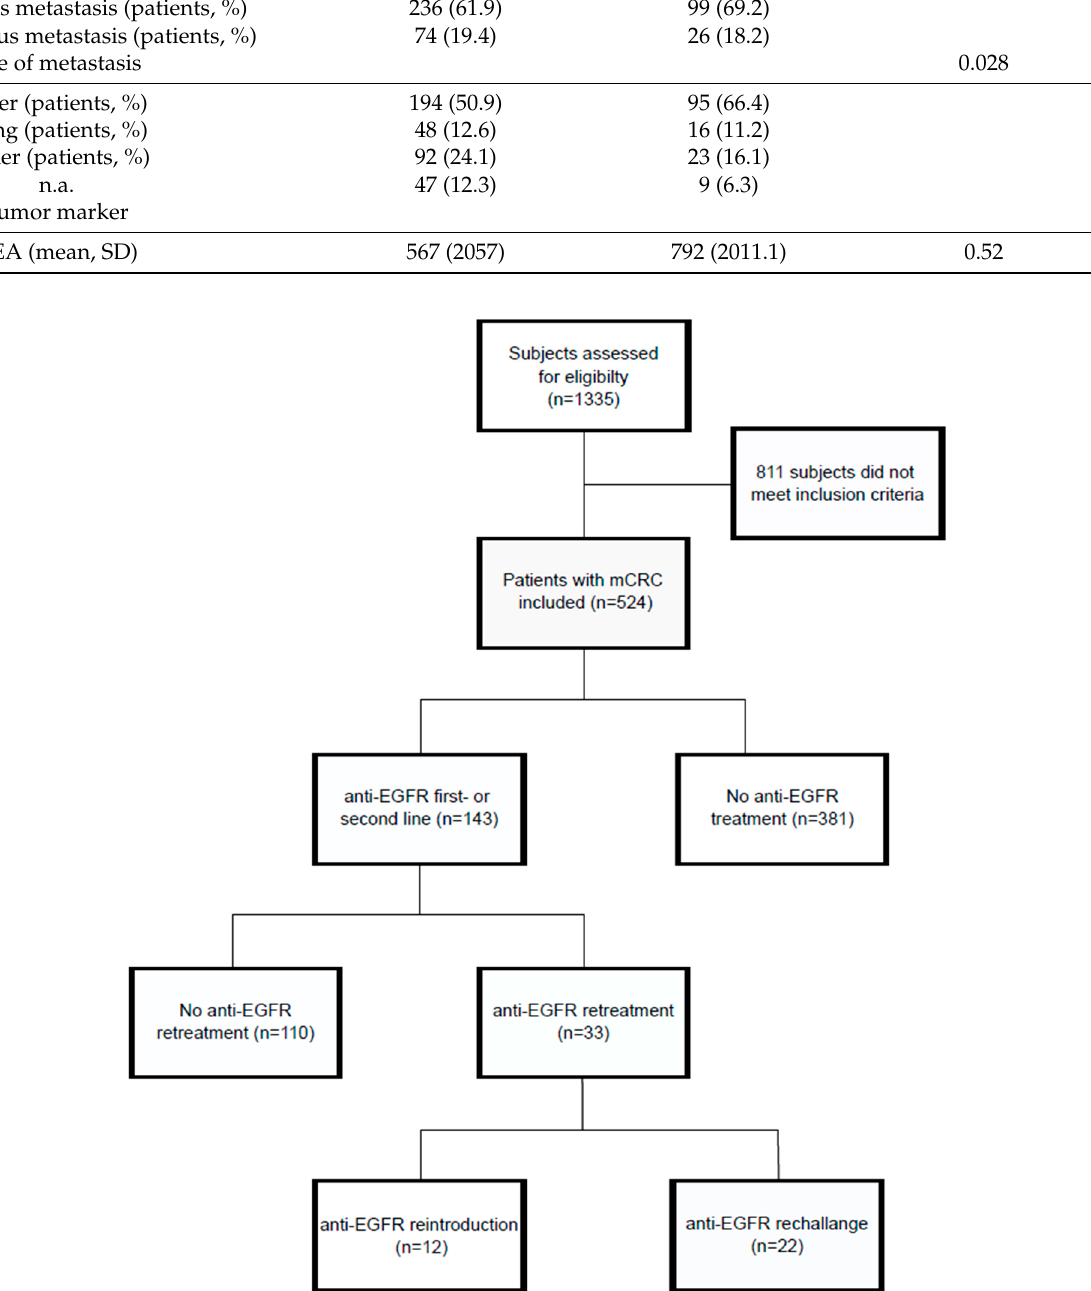
Figure 1. Flow chart depicting the study cohort and assignment into different study groups. Table 1. General patient characteristics in the overall mCRC cohort.